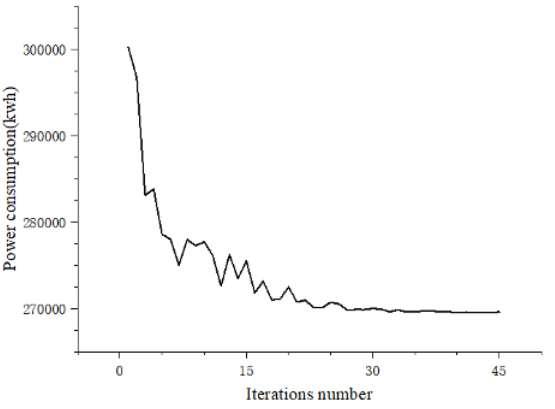
Fig. 5. Change of power consumption during optimization.